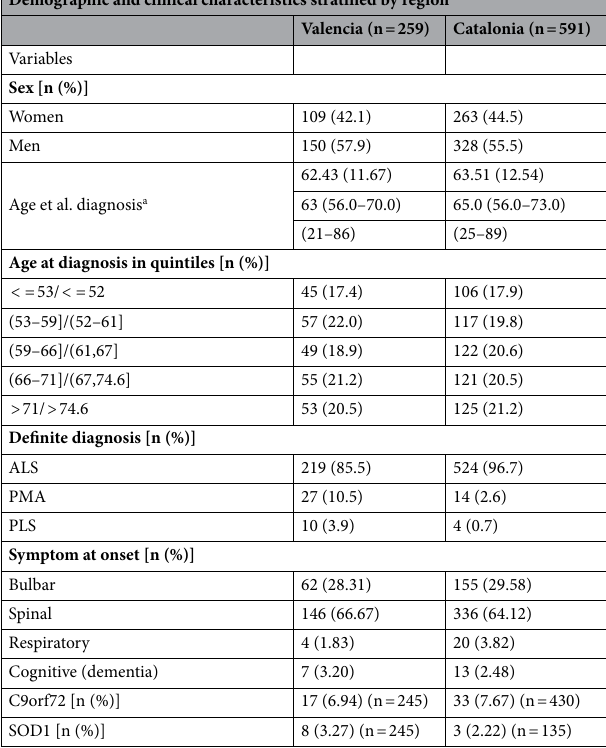
Table 5. Descriptive analysis of demographic and clinical characteristics by region. All patients. ALS Amyotrophic Lateral Sclerosis, PMA Progressive Muscular Atrophy, PLS Primary Lateral Sclerosis. a First row: